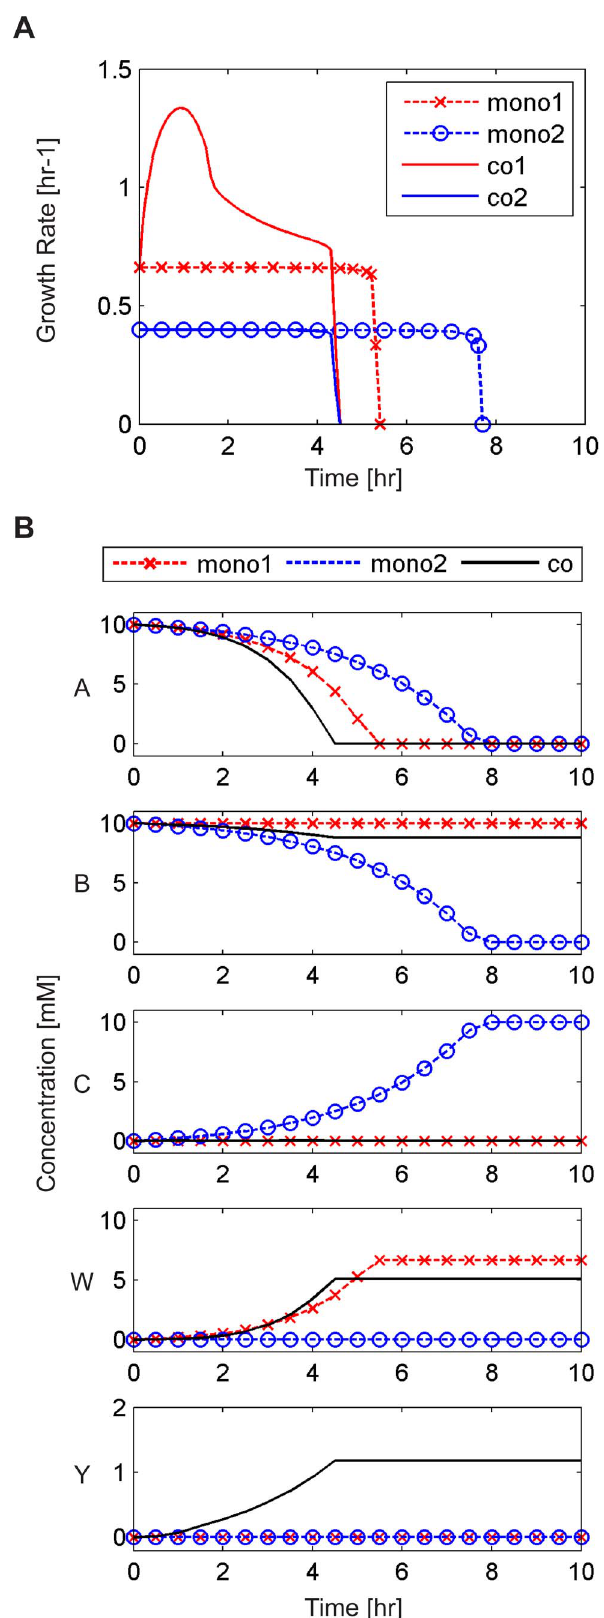
Figure 3. Temporal dynamics obtained by our framework for the mono-cultures and co-culture of the toy ecosystem illustrated in Figure 2. ( A ) Growth rate of the red and blue species in mono-cultures and co-culture. ( B ) The concentration of various metabolites in the medium over time in the mono-cultures and co- culture. Metabolite Y was identified as an emergent metabolite since it was secreted in co-culture (solid line) but was totally absent from either of the two mono-cultures (dashed lines). In contrast, metabolites W and C were observed in the medium in at least one of the mono-cultures (although at different concentrations than in